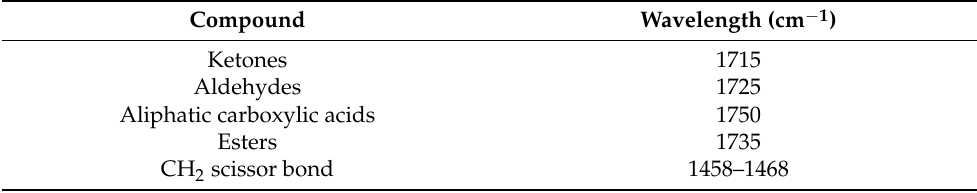
Table 1. FTIR most significant reference bands for this